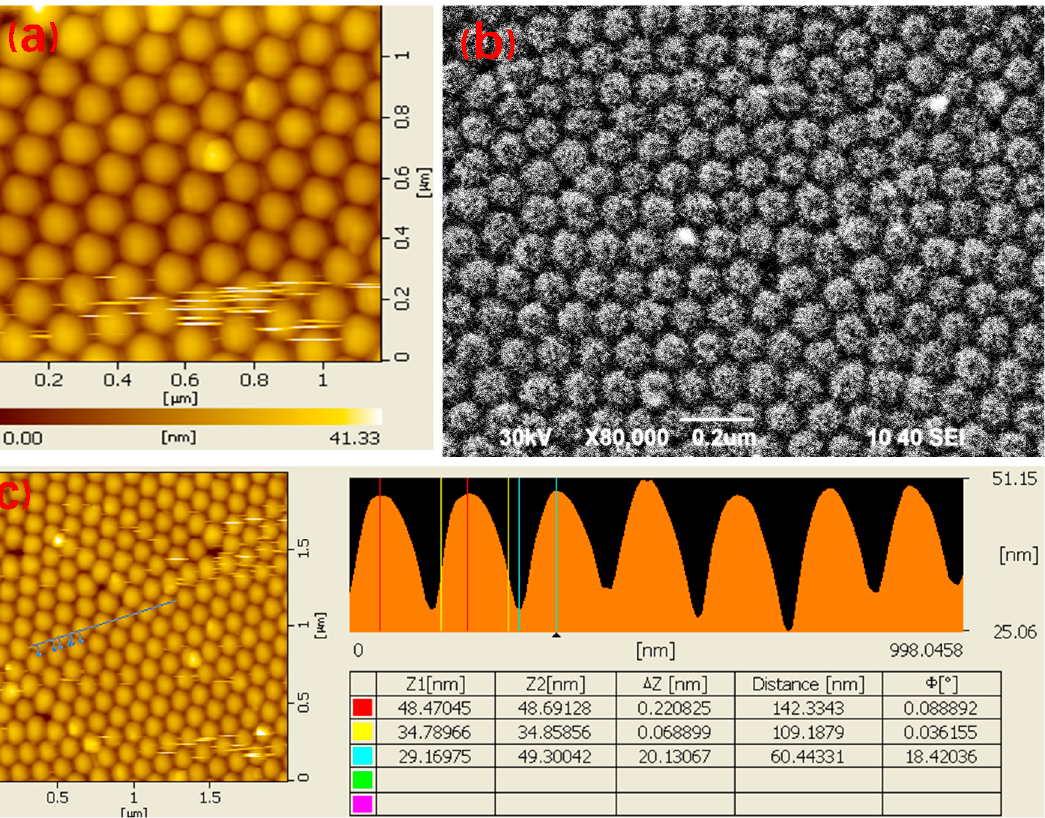
Figure 2. Surface topography of spherical silver nanoarrays: ( a ) 2D AFM image; ( b ) SEM image; and ( c ) geometric dimension analysis.